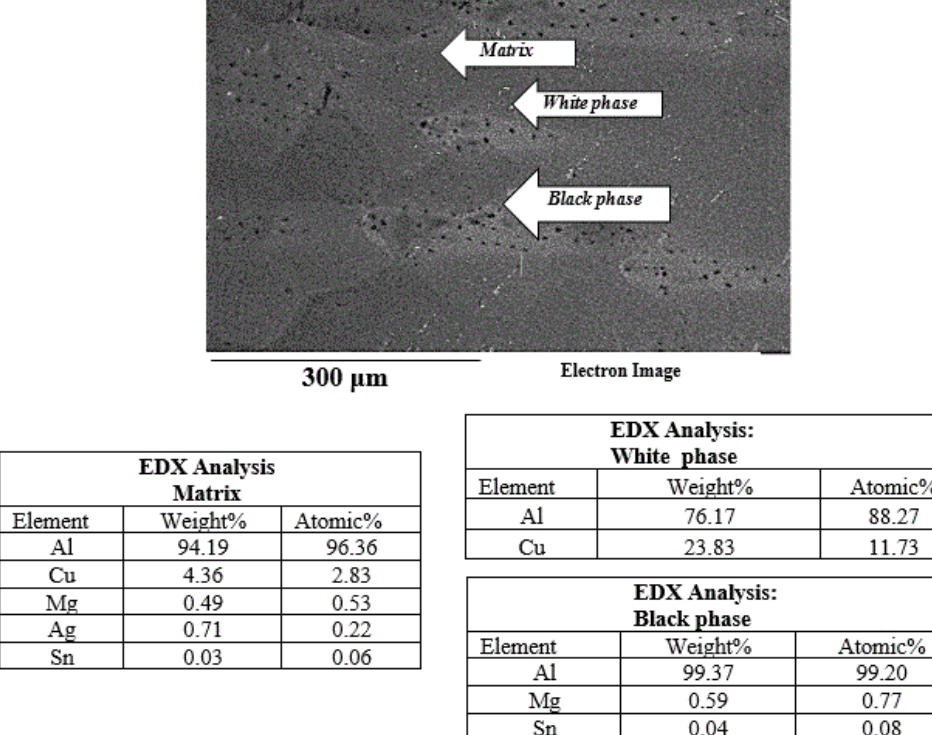
Figure 4. SEM image showing the characteristic features of the precipitate morphology of peak aged treated Alloy-4. Tables of EDS point analysis measurements in selective areas are also included.